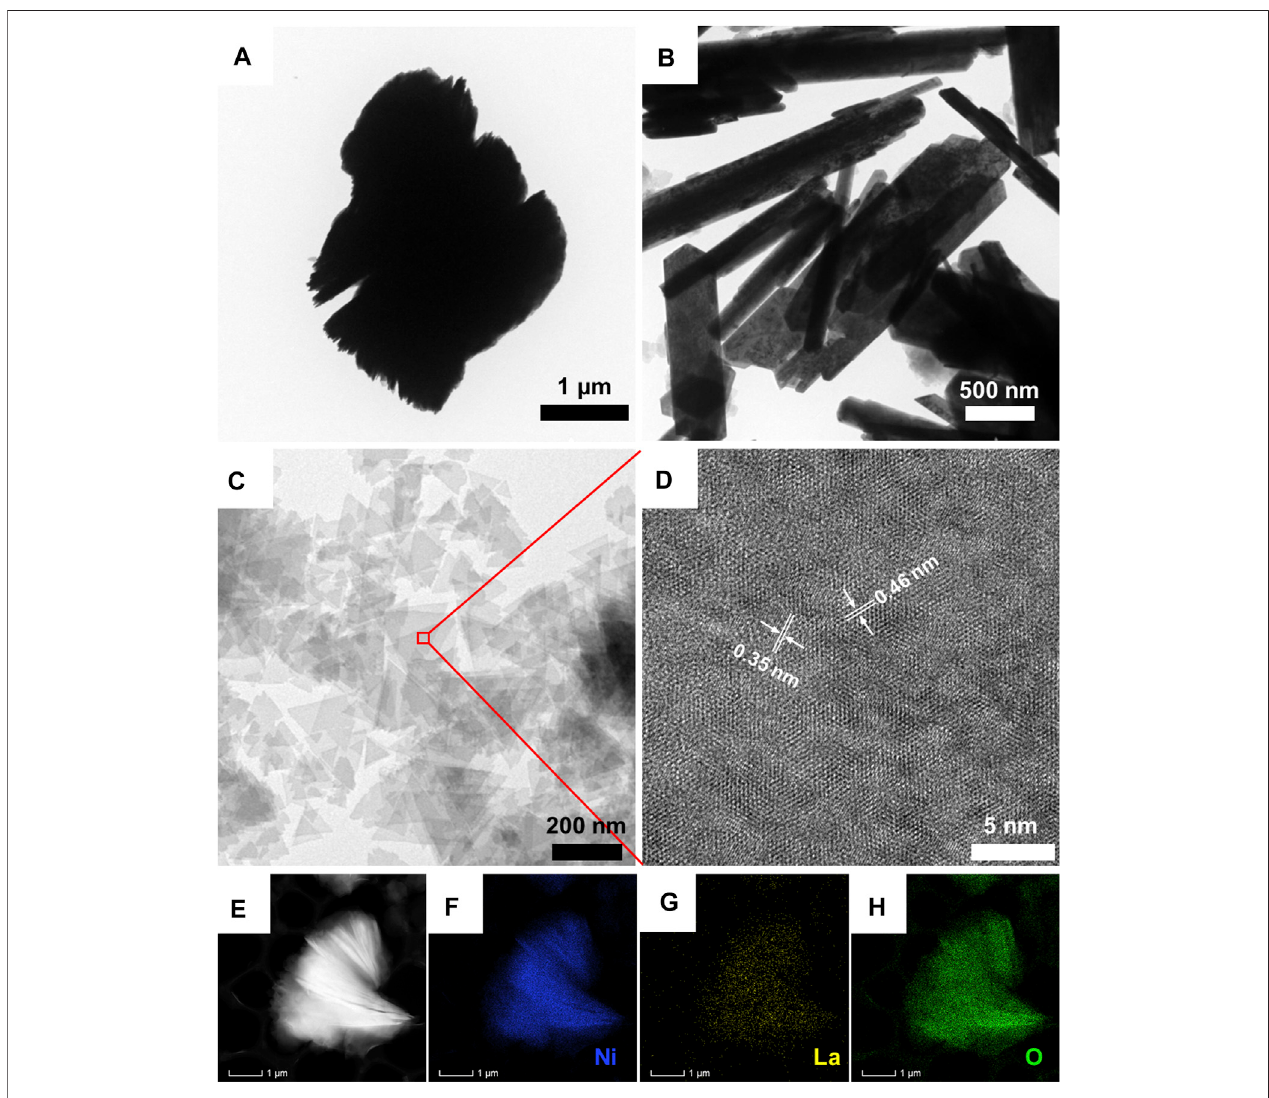
FIGURE 4 | TEM images of (A) pristine Ni(OH) 2 , (B) pristine La 2 O 3 , and (C) LONH; (D) HRTEM image of LONH; (E – H) energy dispersive spectroscopy (EDS) mapping images of LONH.